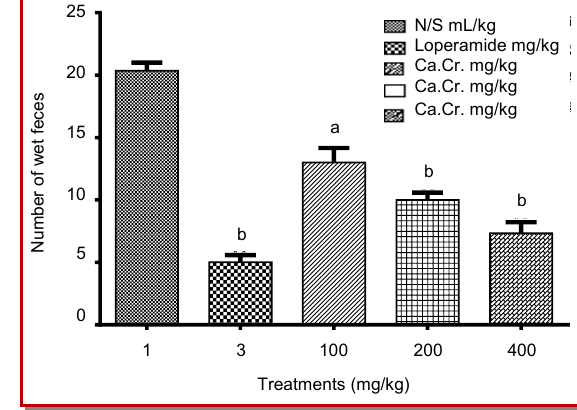
Figure 4: Bar graph showing the response of Ca.Cr. 150 mg/kg on chick emesis model. Values are shown as the mean ± SEM. Data were analyzed by unpaired t-test considering p<0.05 as significant. When data were compared with control it showed significant antiemetic activity( a p<0.01)